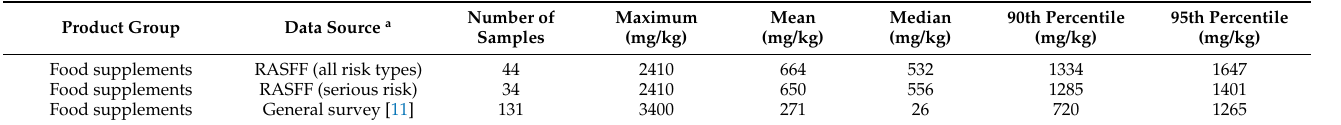
Table 1. Distribution of ∆ 9 -tetrahydrocannabinol in food